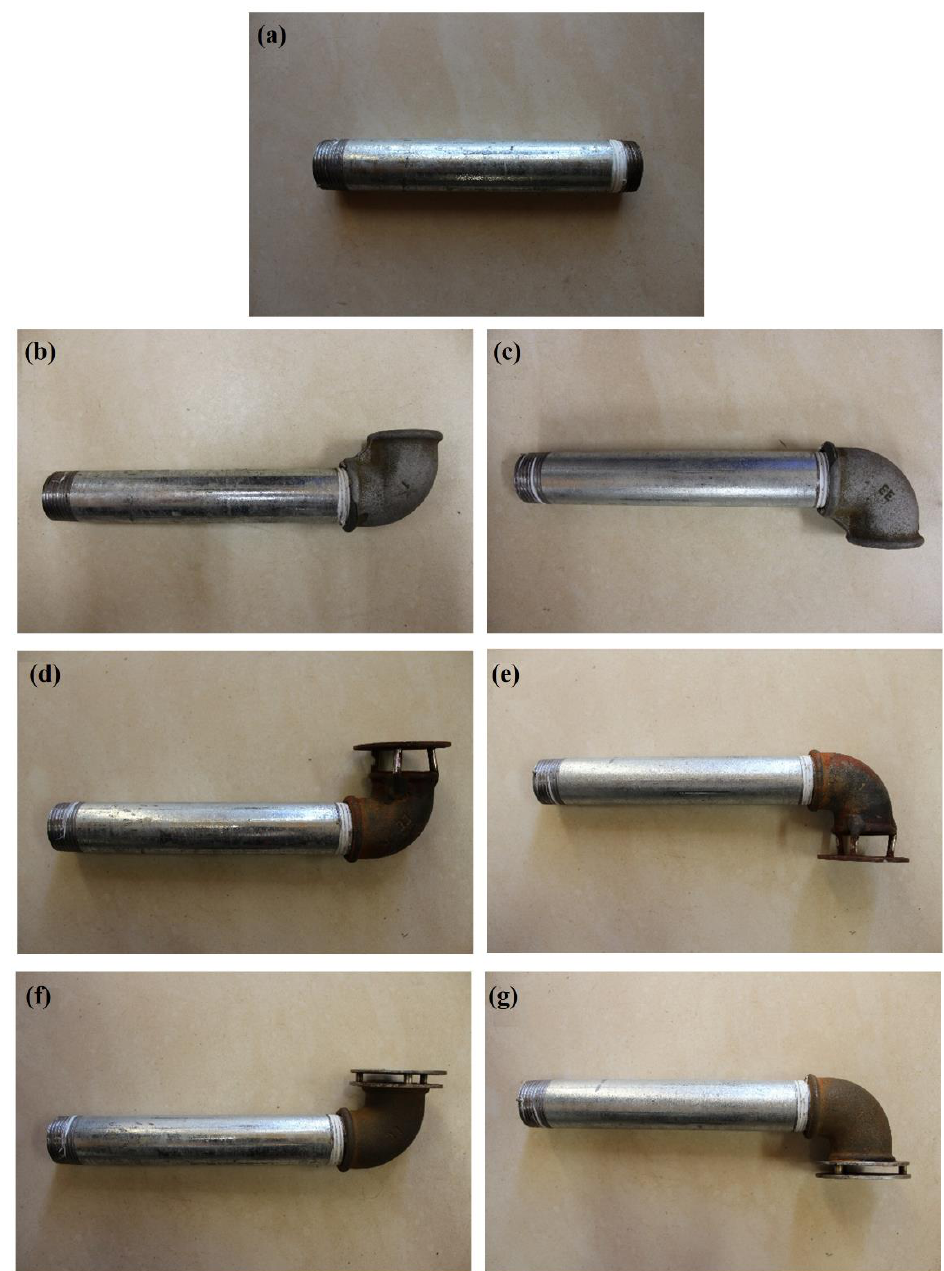
Figure 4. Inlet variants used in the test: ( a ) inlet W1 ; ( b ) inlet W2 (elbow directed upwards); ( c ) inlet W3 (elbow directed downward); ( d ) inlet W4 (elbow directed upwards with a single plate); ( e ) inlet W5 (elbow directed downward with a single plate); ( f ) inlet W6 (elbow directed upwards with a double plate); ( g ) inlet W7 (elbow directed downward with a double plate).